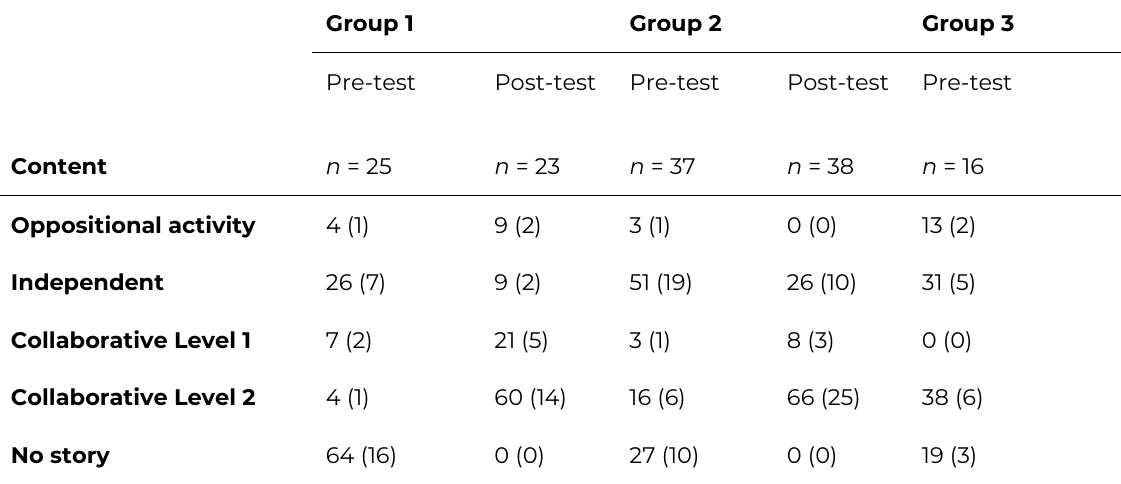
Table 7: Percentage (N) of type of collaboration content by group and time of